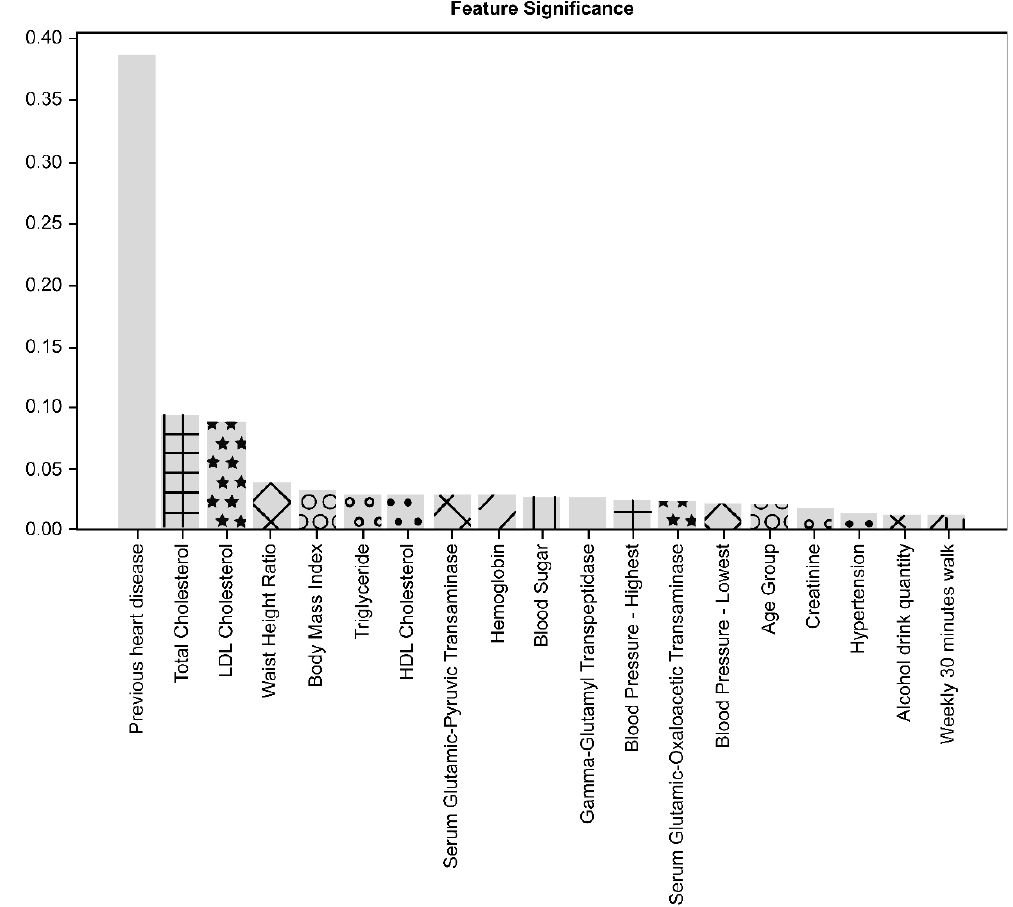
Figure 3. Importance analysis of contributing factors with the feature importance method. Previous CVD was the most important factor, followed by TC, LDL cholesterol, waist-to-height ratio, and body mass index.